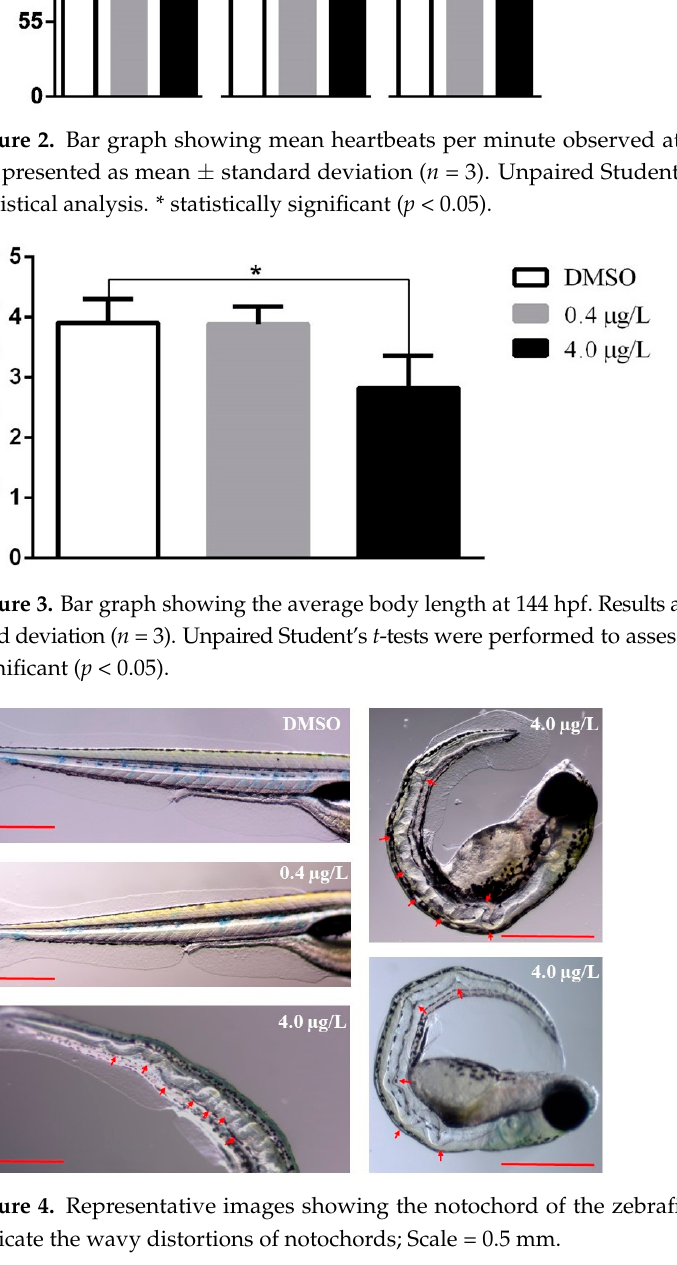
Figure 2. Bar graph showing mean heartbeats per minute observed at 48, 72, and 96 hpf. Results are presented as mean ± standard deviation ( n = 3). Unpaired Student’s t-test was performed for statis- tical analysis. * statistically significant ( p < 0.05).